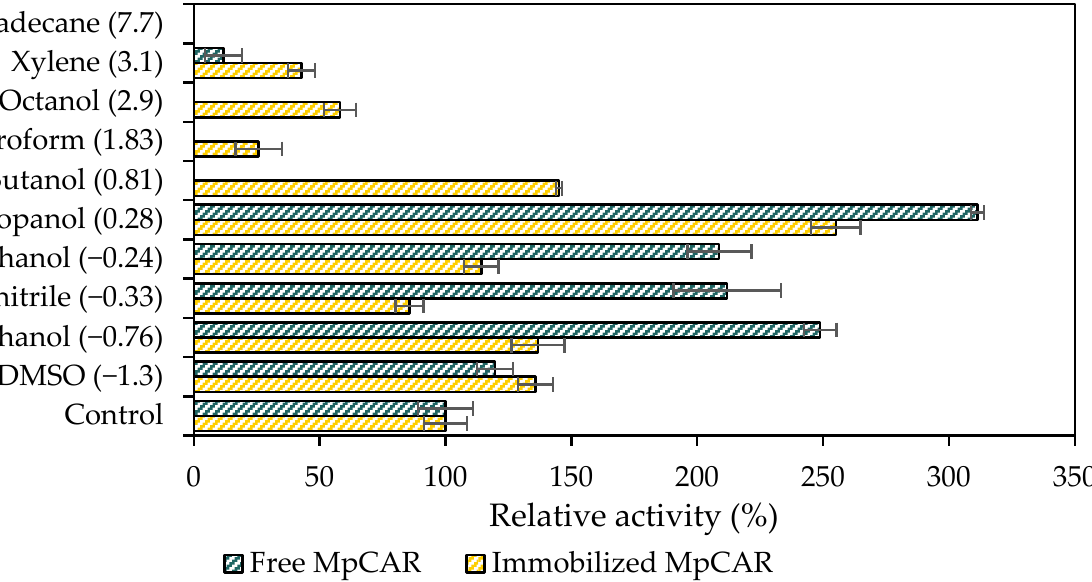
Figure 5. Effect of organic solvents on the stability of free and immobilized carboxylic acid reductase from Mycobacterium phlei ( Mp CAR). Green columns: relative activity of free Mp CAR; yellow columns: relative activity of immobilized Mp CAR onto Seplite LX120. Log p is the partition coefficient of the solvent between water and octanol. Samples were measured in triplicates.